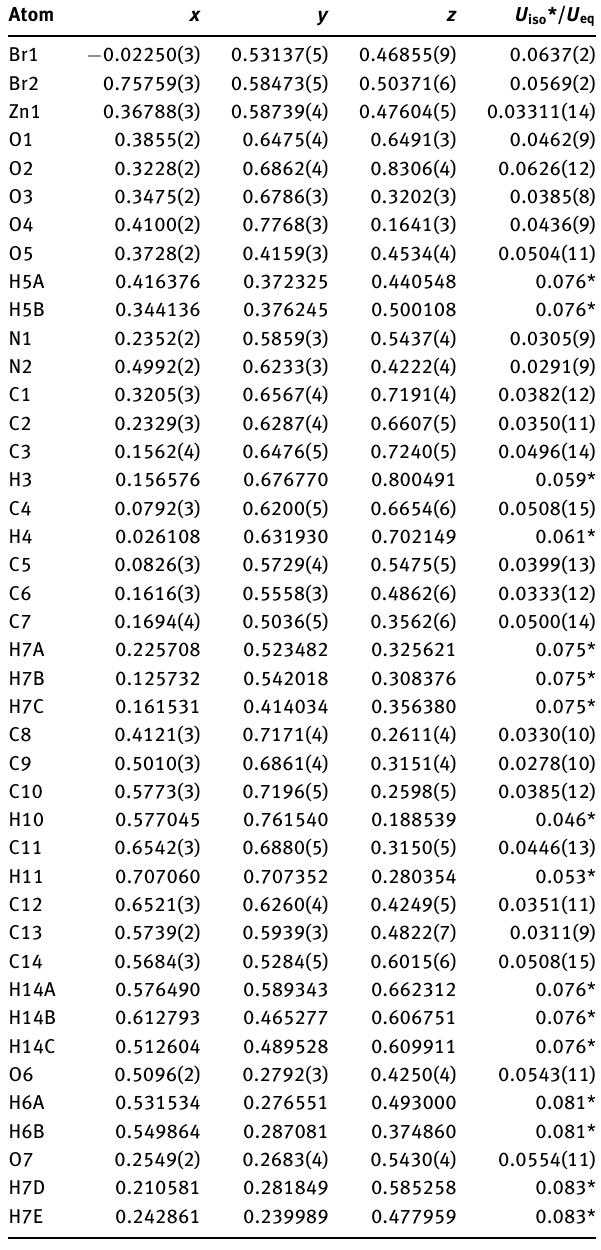
Table 2: Fractional atomic coordinates and isotropic or equivalent isotropic displacement parameters (Å 2